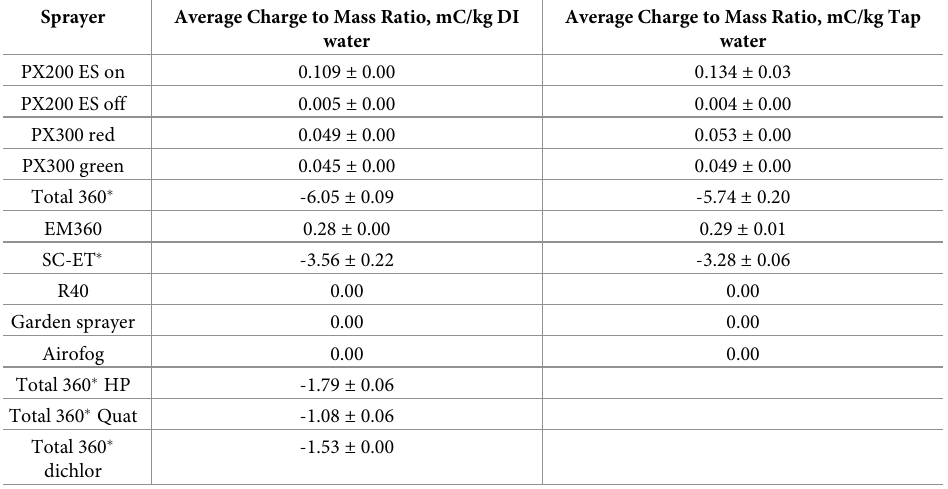
Table 4. Charge/mass ratio for